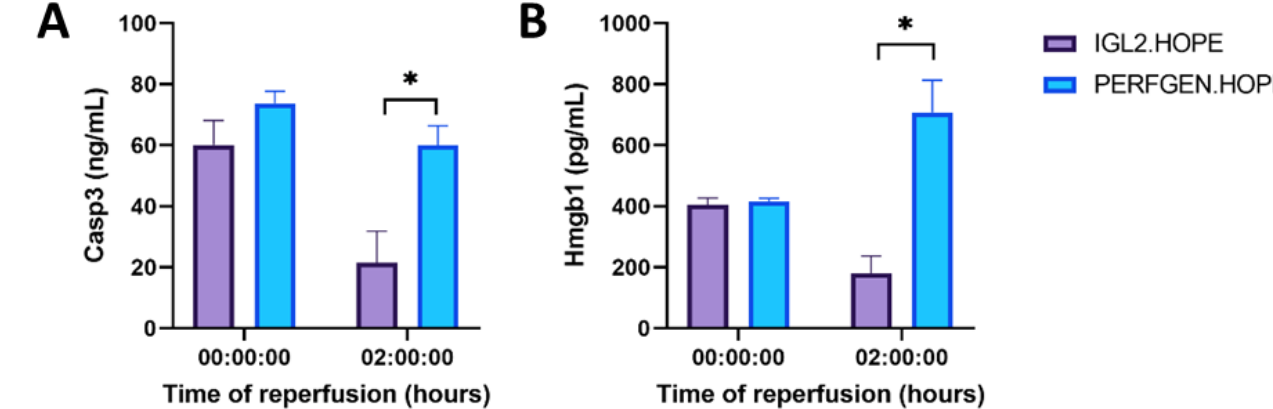
Figure 8. Expression of apoptosis-related marker active caspase 3 and inflammation marker HMGB1 in the perfusate during reperfusion following 24 h of SCS and 2 h of HOPE. Caspase 3 ( p = 0.02) and HMGB1 ( p = 0.03) were significantly less expressed in the IGL2 group after 2 h of reperfusion. n = 6/group . * = p < 0.05.